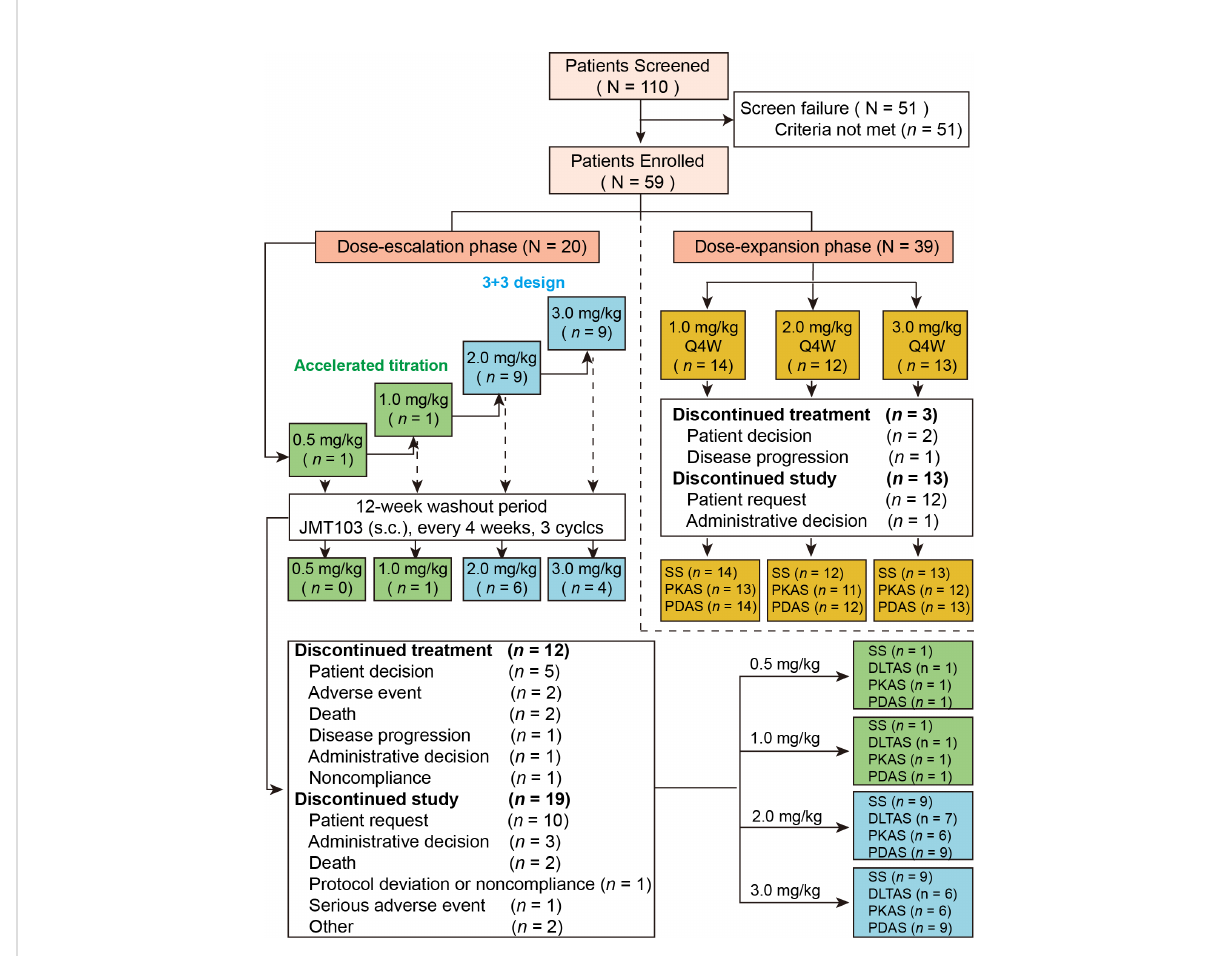
FIGURE 1 Study fl ow and patient disposition. SAS, safety analysis set; PKAS, PK analysis set; PDAS, PD analysis set; DLTAS, DLT analysis set; PD, pharmacodynamic; PK, pharmacokinetic; s.c., subcutaneous; Q4W, every 4